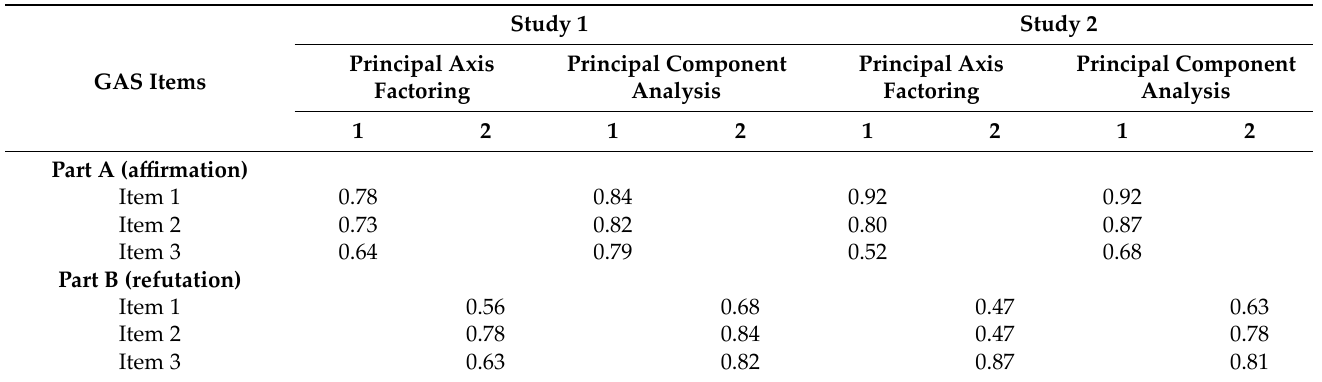
Table 1. Rotated factors and component matrices using principal axis factoring and principal com‑ ponent analysis for the Goal Ambivalence Scale (GAS) items. Study 1 Study